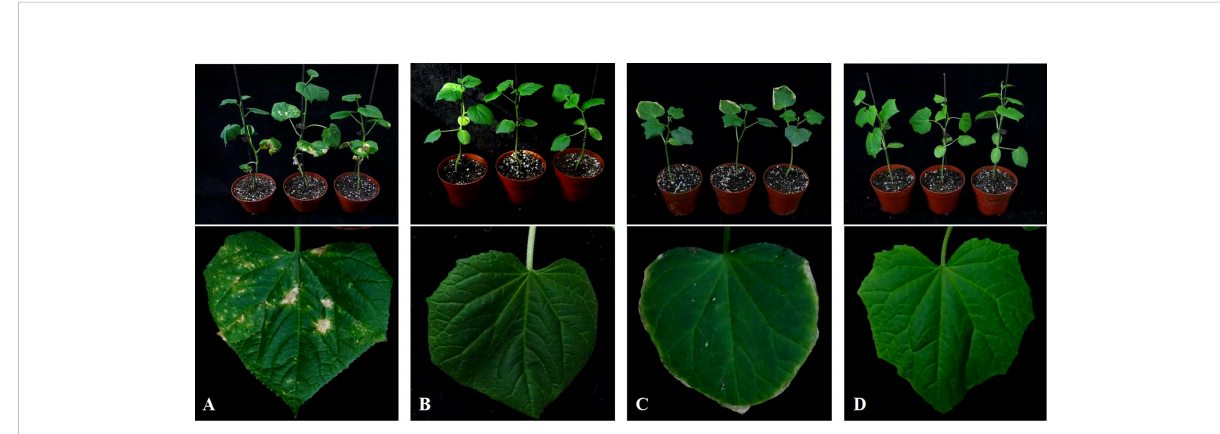
FIGURE 2 Effects of different soil treatments on leaf spot of cucumber seedlings. (A) Plant debris was mixed with sterile soil (CC). (B) Plant debris was mixed into the soil and covered with polyethylene fi lm (CC-PE). (C) Plant debris was mixed into the soil, and CaCN 2 (CC-CaCN 2 ) was added. (D) Natural soil without any treatment (CK).